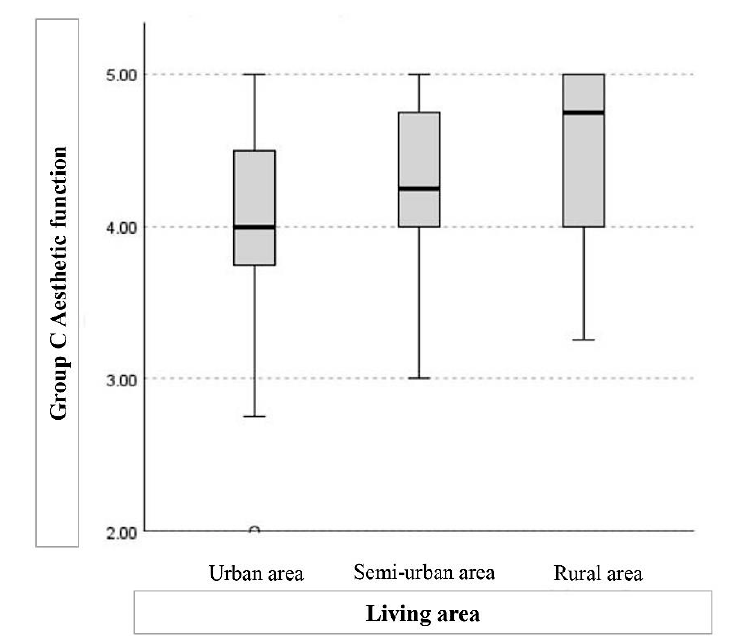
Figure 6. Independent samples Kruskal–Wallis test between aesthetic function and living area groups.